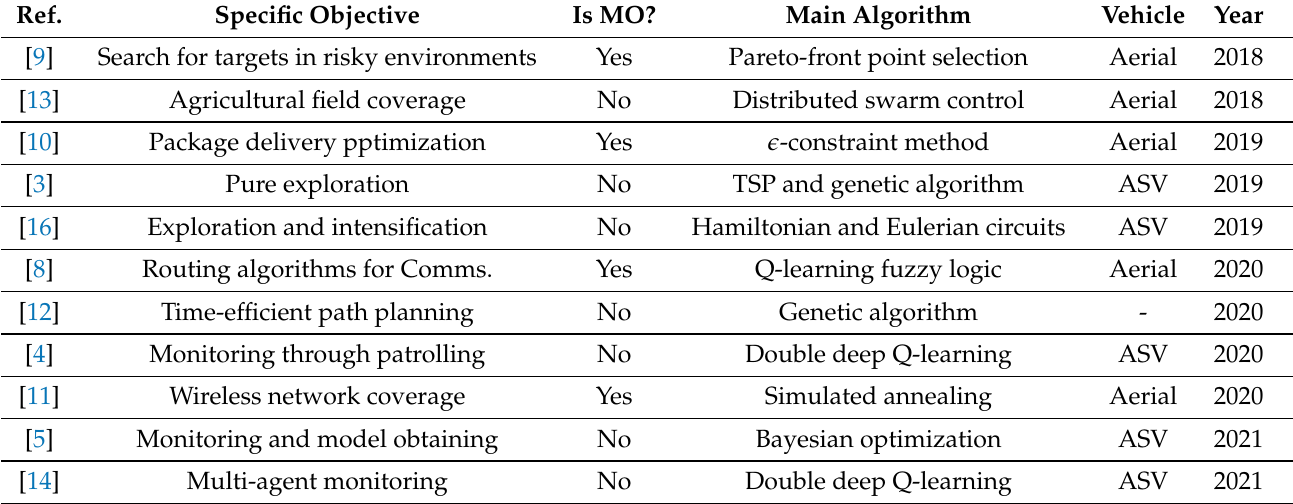
Table 1. Brief summary of related works. Specifying whether the work is Multi-Objective (MO) or not.